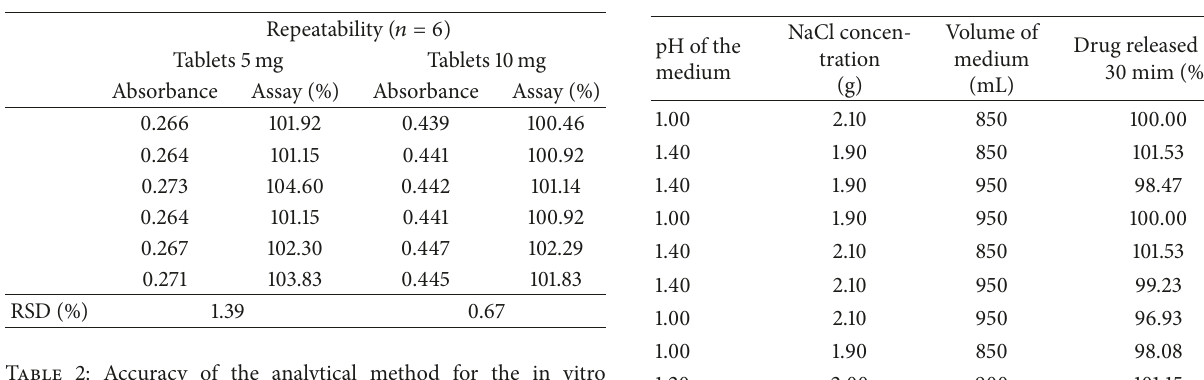
Table 3: Robustness test (Factorial analysis 2 3 ) of the analytical method for the in vitro dissolution of dapagliflozin.